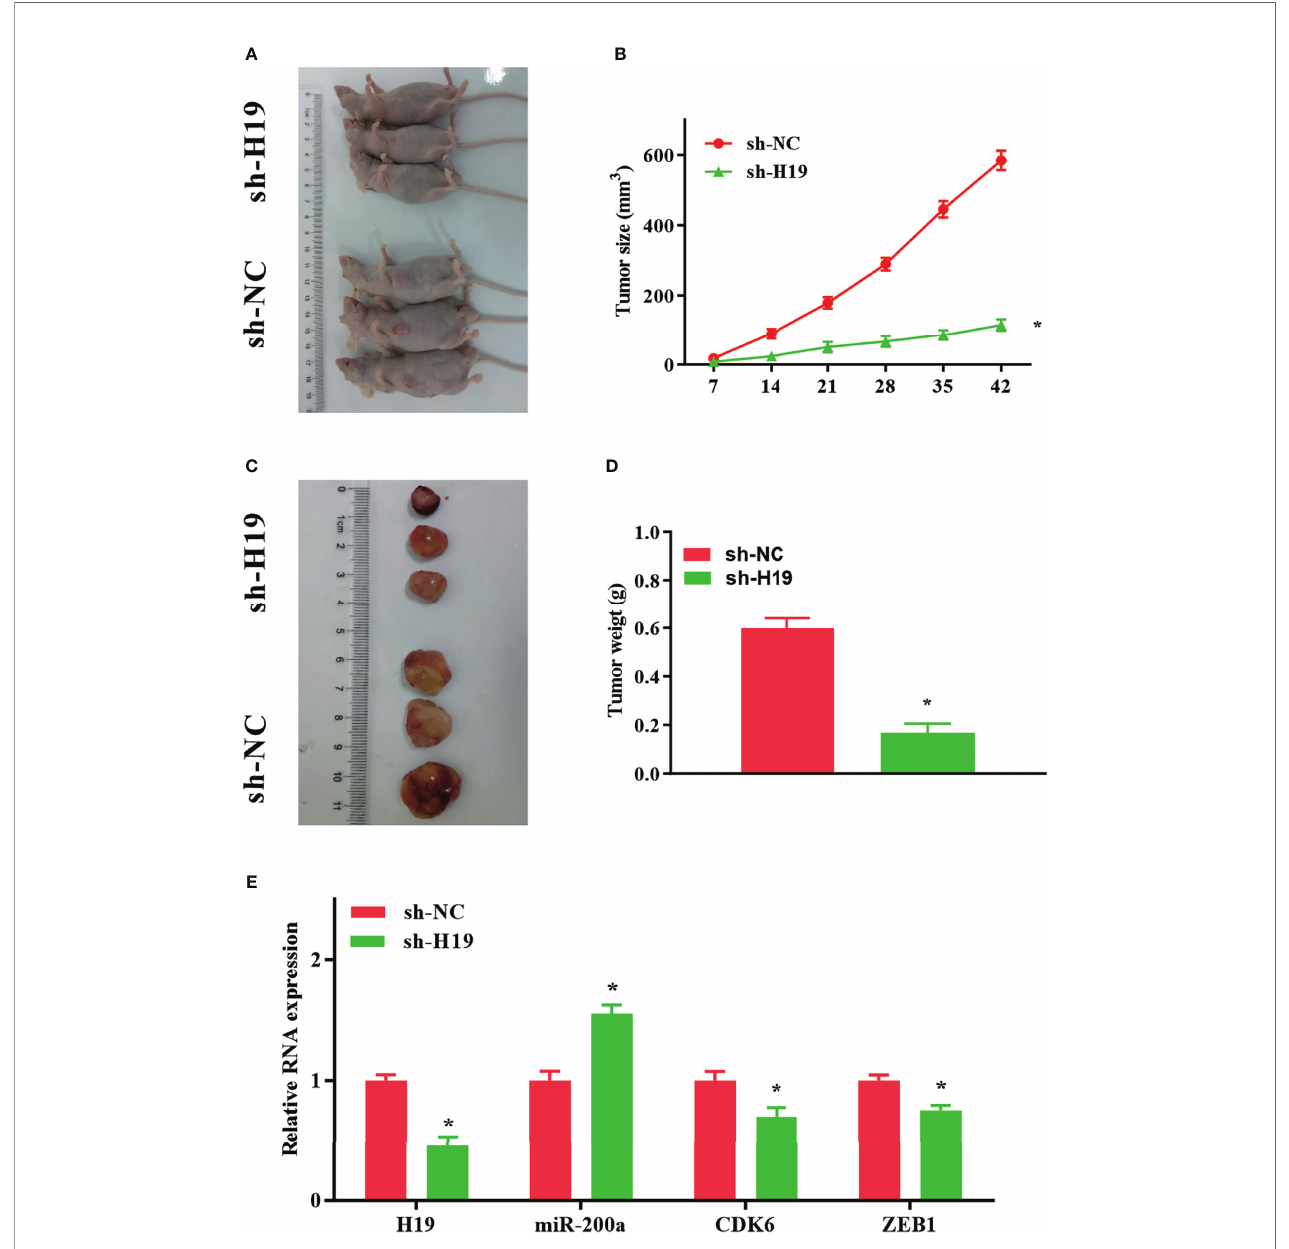
FIGURE 5 | Knockdown of H19 suppressed the tumour progression of glioma in mouse model. (A, C) Seven weeks following injection, mice were sacri fi ced and tumor tissues were isolated. (B, D) The average tumour size and weight were remarkably decreased in H19 knockdown group compared with the control. (E) The levels of H19, CDK6 and ZEB1 were downregulated, and miR-200a was upregulated in H19 knockdown mice, respectively. Data were presented as mean ± SEM ( n = 5 animals in each group); * P < 0.05 vs control group. NC, negative